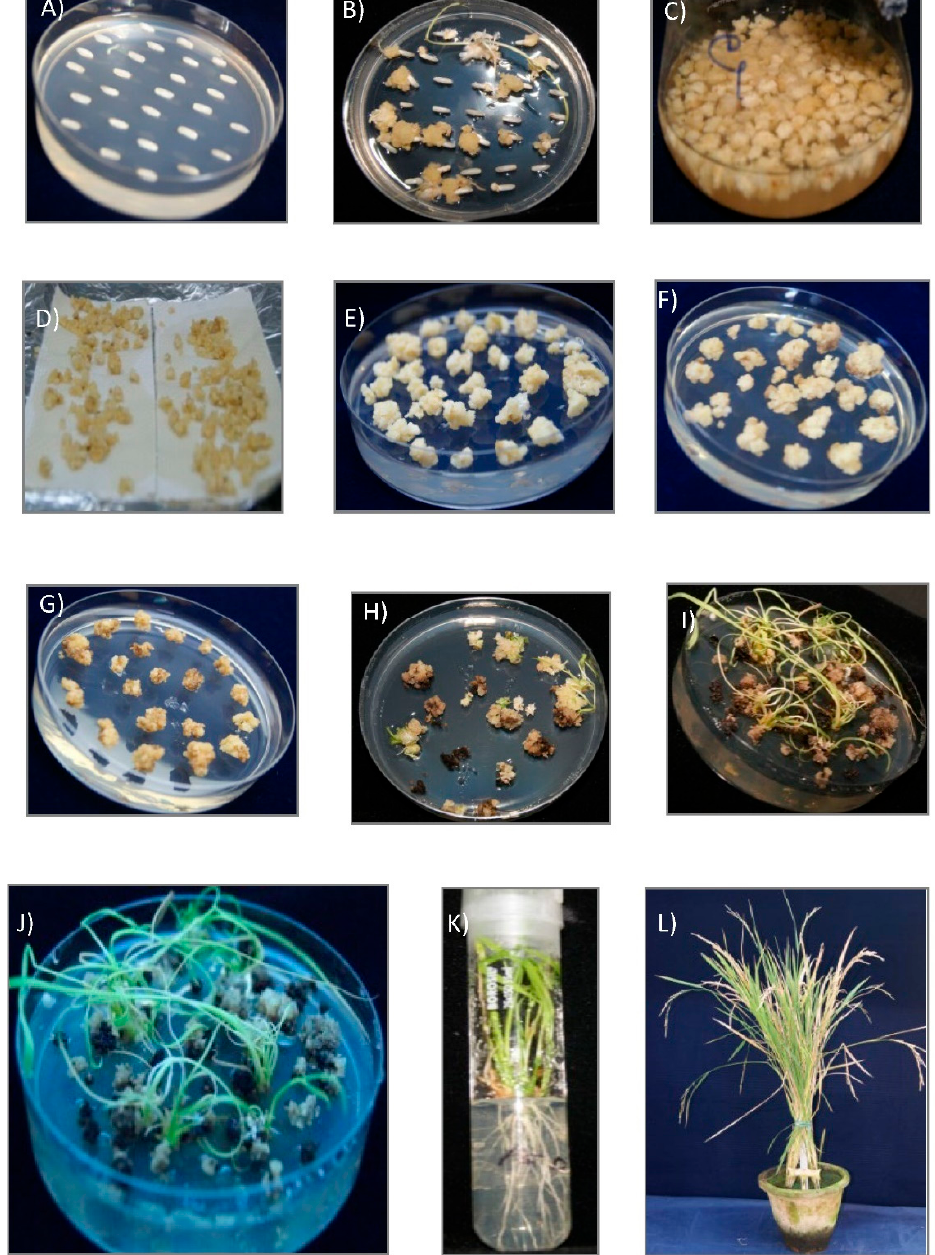
Figure 3. The plant transformation through plants tissues cultures using the calli method, targetting isoform SSSII gene, mediated by Agrobacterium. ( A , B ) Calli induction in the dark, ( C , D ) co-cultivation/infection with agrobacterium, ( E – G ) selection of healthy calli for regeneration kept at dark with optimum condition, and ( H ) calli for pre-regeneration. ( I , J ) Regeneration calli kept in the light ( K ) for rooting and ( L ) hardening of plants in the greenhouse under optimum conditions.